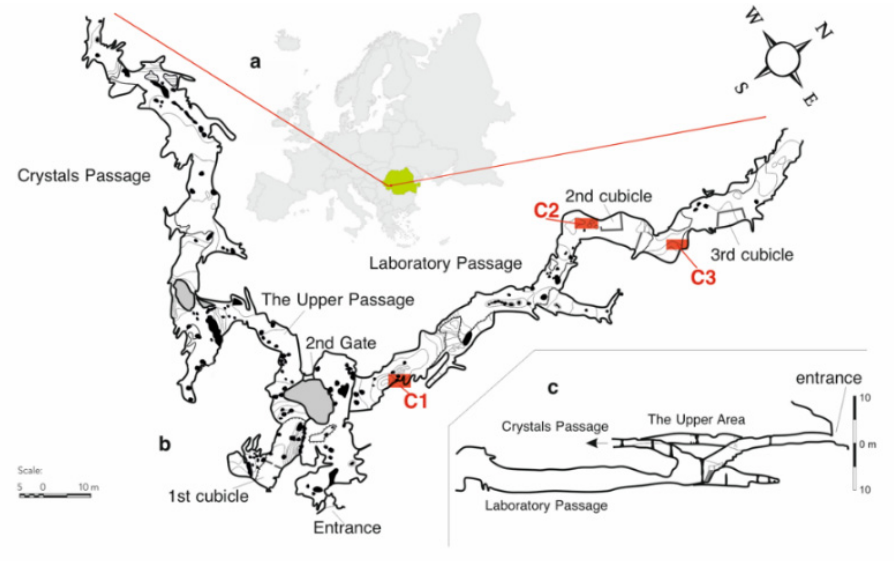
Figure 8. The location of Clo ș ani Cave in the southwestern part of Romania ( a ). The sampling points (C1—silty soil samples and C2 and C3—pool water samples) in the laboratory passage ( b ). The pro- file of the cave ( c ).